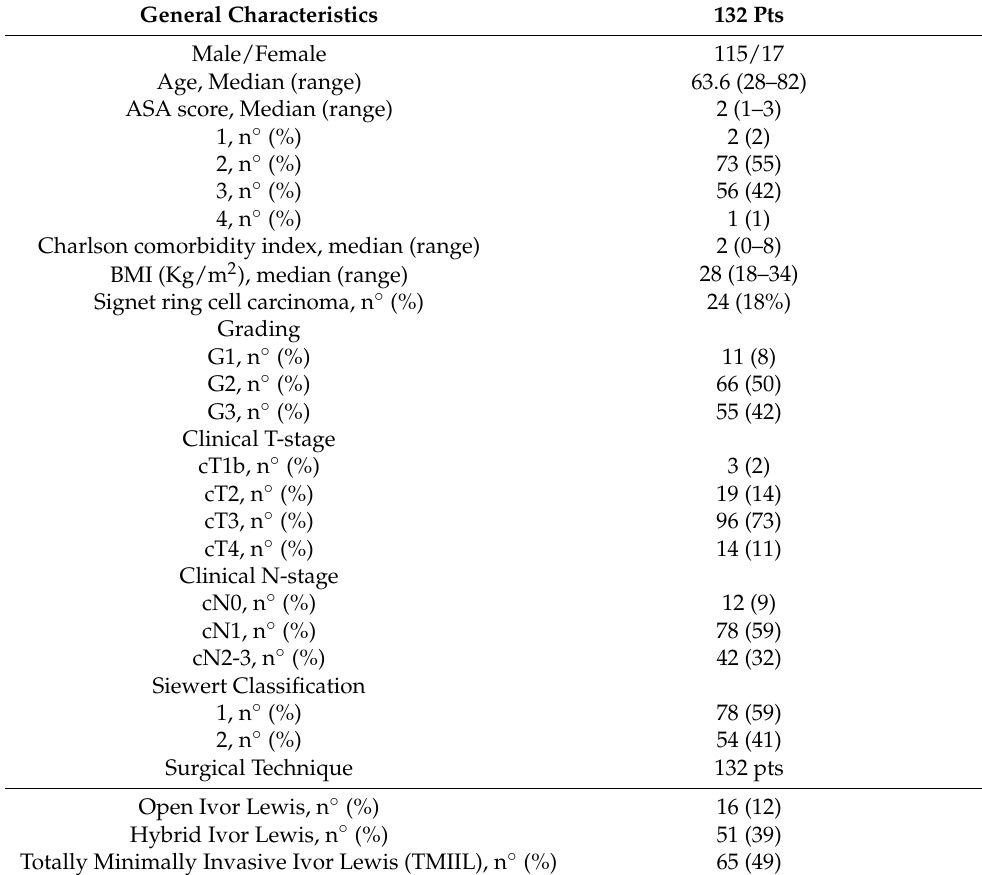
Table 1. General characteristics and surgical approach.